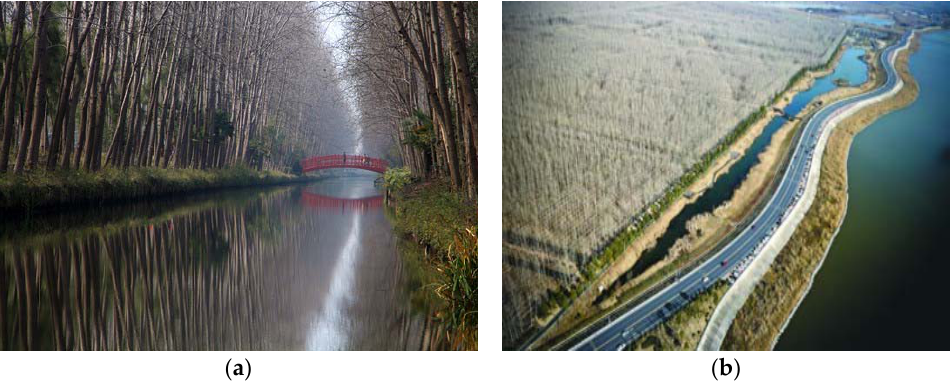
Figure 3. ( a ) Lakeside Wetland Park; and ( b ) aerial view of Lakeside Wetland Park.